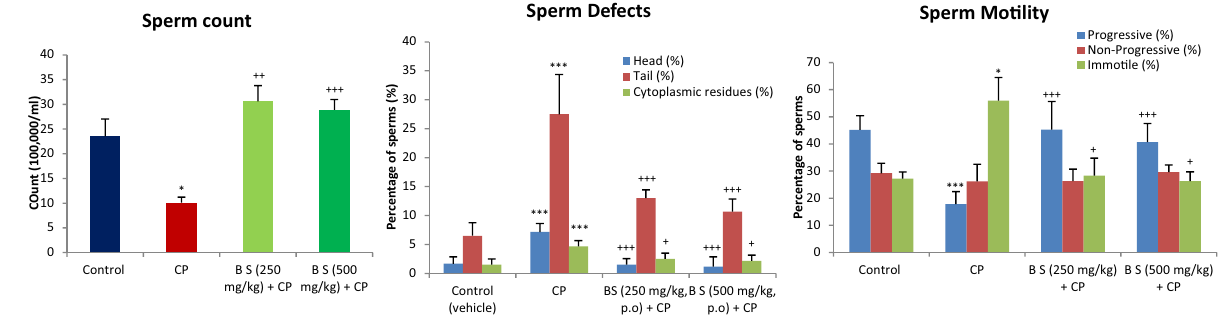
Figure 3. Effect on different sperm parameters. All values are mean ± SEM, n = 6. * P < 0.05, ** P < 0.01, *** P < 0.001 compared to control. + P < 0.05, ++ P < 0.01, +++ P < 0.001 compared to CP treated group CP = cyclophosphamide (200 mg/kg, i.p), B S Boswellia sacra extract.